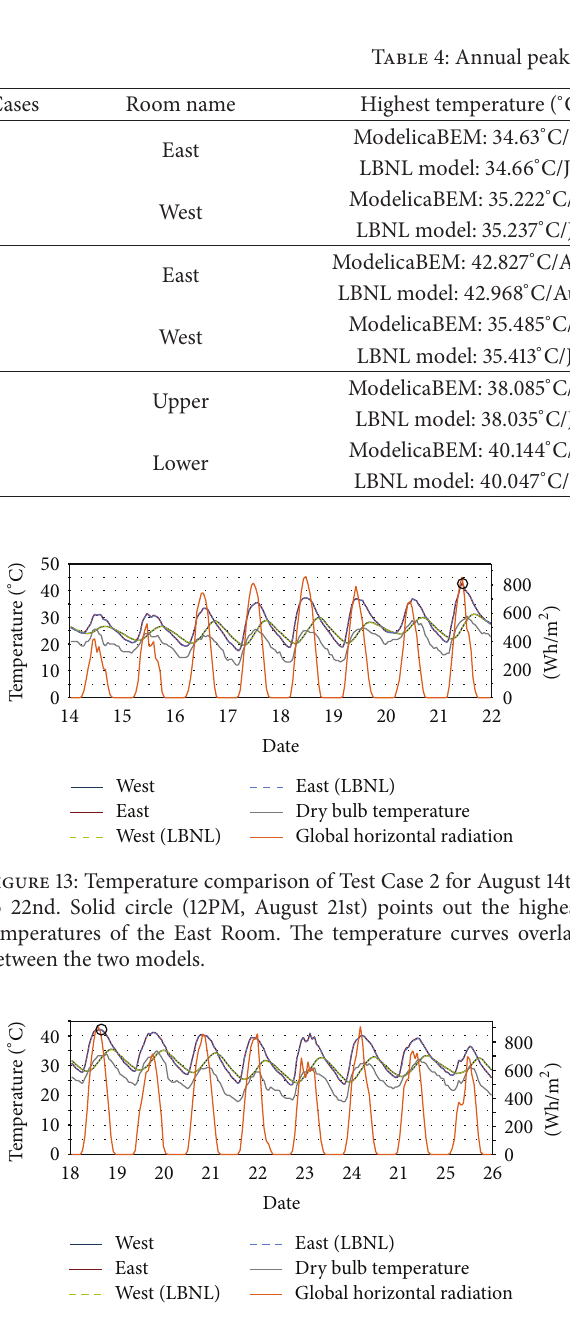
Figure 14: Temperature comparison of Test Case 2 for July 18th to 26th. Solid circle (6PM, July 18th) presents the highest temperatures of the West Room. The temperature curves overlap between the two models.